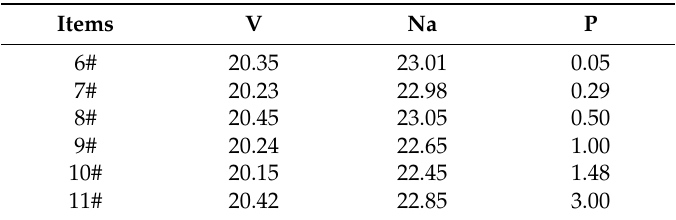
Table 2. Main chemical composition of the simulated feed vanadium solutions with different phosphorus concentrations, g/L. Items V Na P 6#